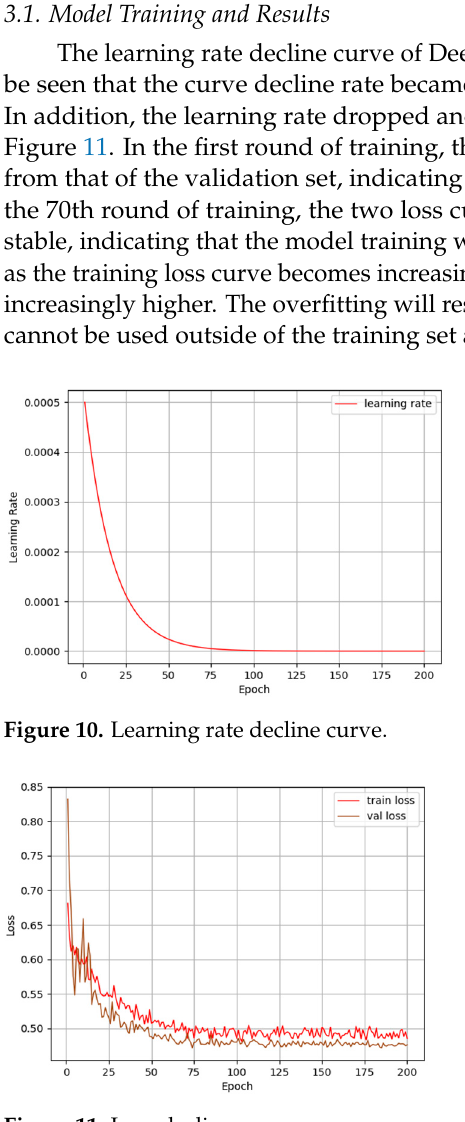
Figure 11. Loss decline curve.